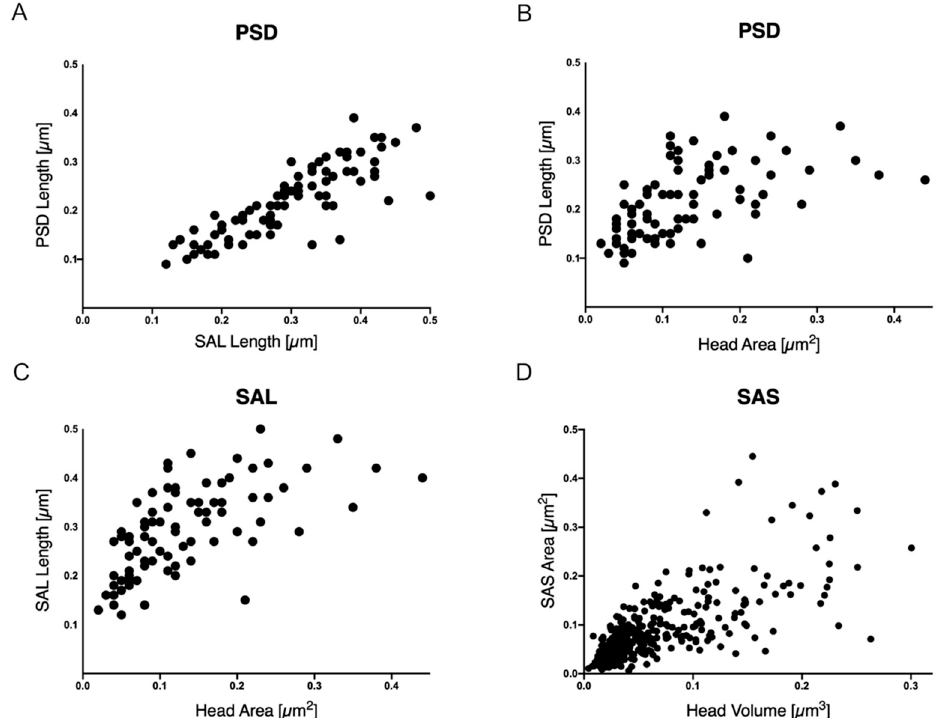
Figure 4. Relationship between the spine head area and volumes with PSD length, SAL and SAS. The correlation between these parameters is reported as graphic representation here: ( A ) SAL length ( µ m) and PSD length ( µ m); ( B ) spine head area ( µ m 2 ) and PSD length ( µ m); ( C ) spine head area ( µ m 2 ) and SAL length ( µ m); ( D ) spine head volume ( µ m 3 ) and SAS area ( µ m 2 ). These values derive from the analysis of more than 80 dendritic spines from 2D TEM sections and more than 340 spines segmented and reconstructed into 3D objects from samples of mouse CA1.